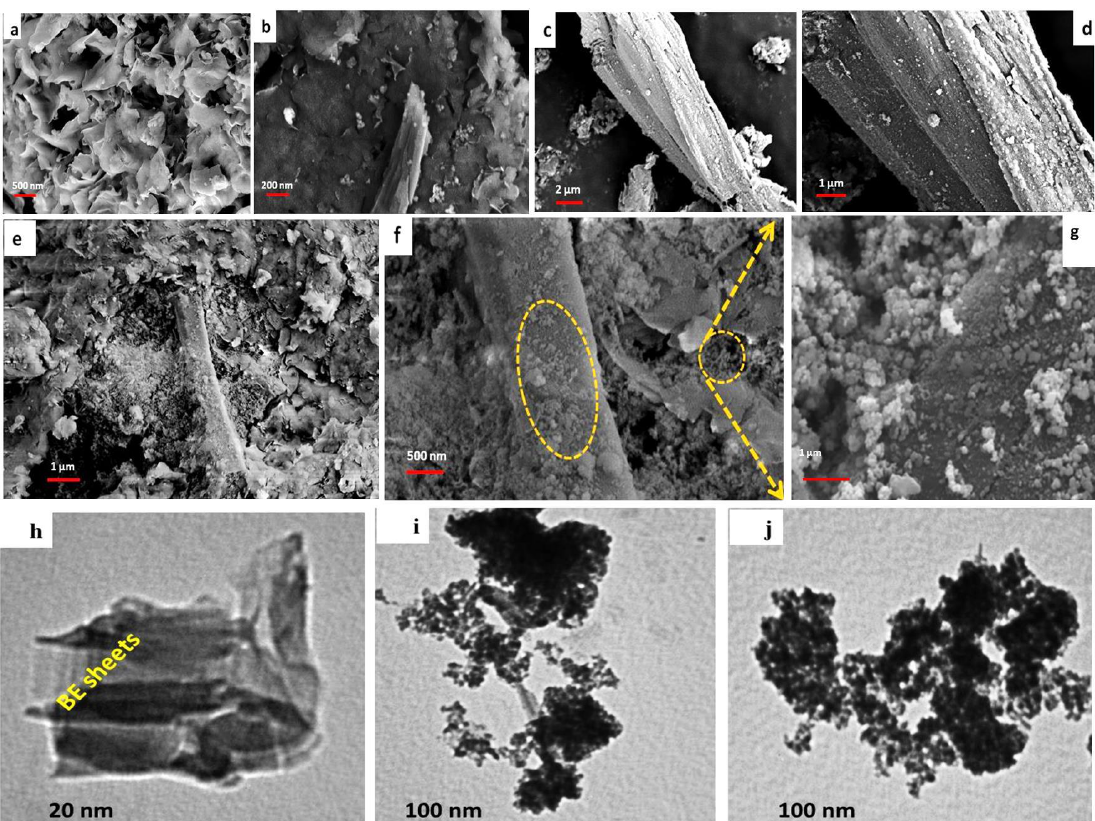
Figure 2. Characterization of the studied samples: FESEM images of BE ( a ), BE/SD ( b – d ), BE/SD – MNPs ( e – g ), TEM images of BE ( h ), and BE/SD – MNPs ( i , j ). An FTIR spectrum of the developed BE/SD – MNPs composite is shown in Figure 3.